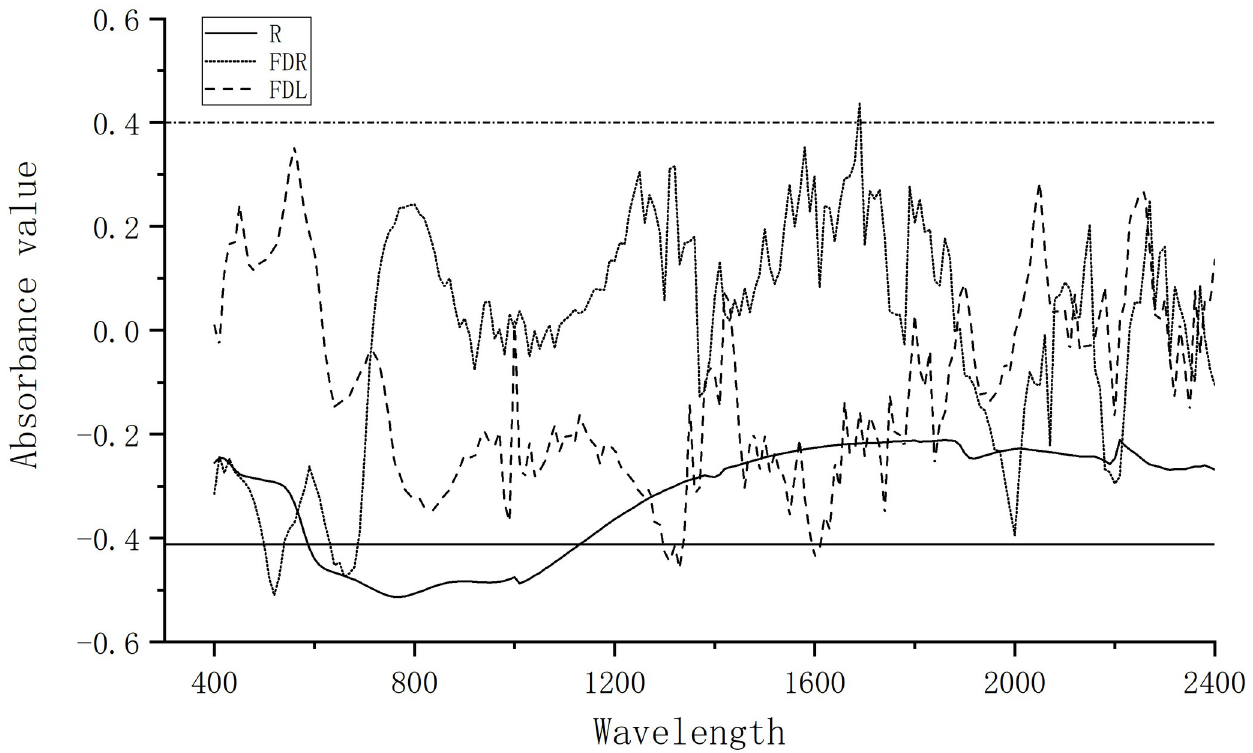
Fig 4. Correlation coefficient between soil organic matter and spectral reflectance.